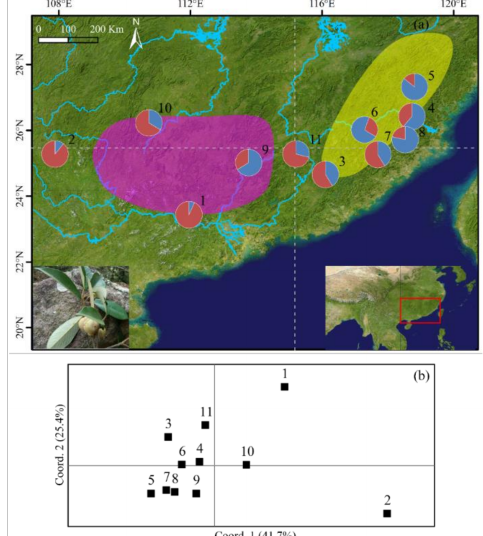
Figure 3. Spatial genetic patterns of Quercus chungii . ( a ) Pie charts represents the genetic structure of populations inferred from Bayesian cluster analysis. The red and blue colors represent the proportion of di ff erent genetic cluster respectively. The purple and yellow covered region represent the range of Nanling and Wuyi Mountains, respectively. ( b ) Plot of the first two coordinates of the principal coordinates analysis (PCoA) at population level based on the nSSR pairwise di ff erentiation matrix for Q. kerrii